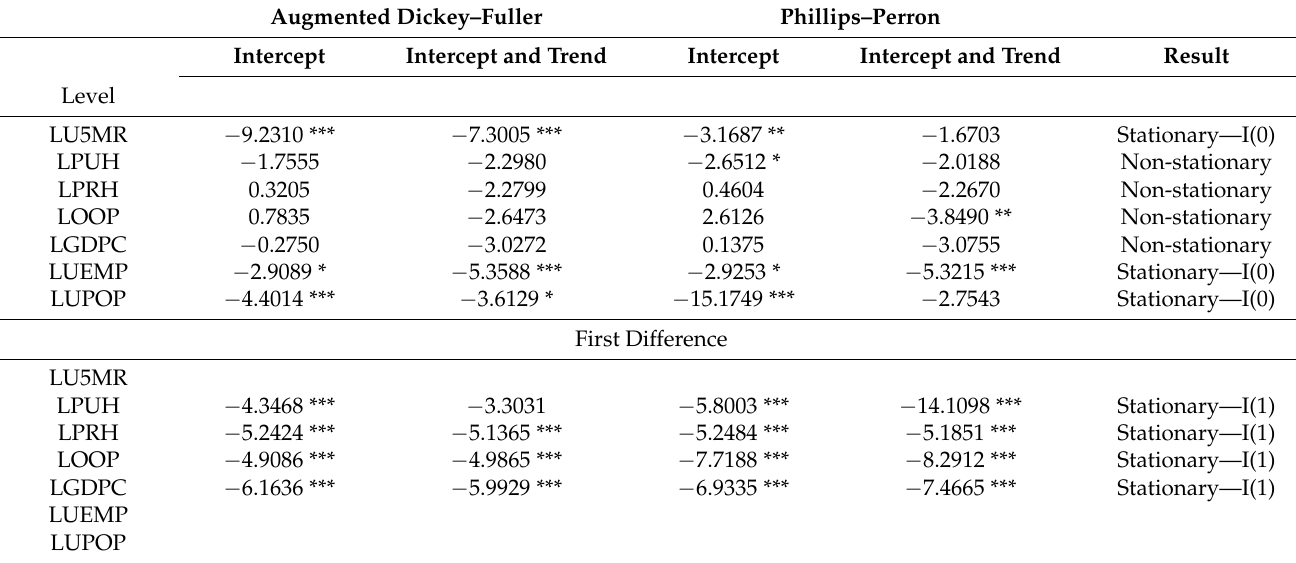
Table 2. Augmented Dickey–Fuller and Phillips–Perron unit root test results.